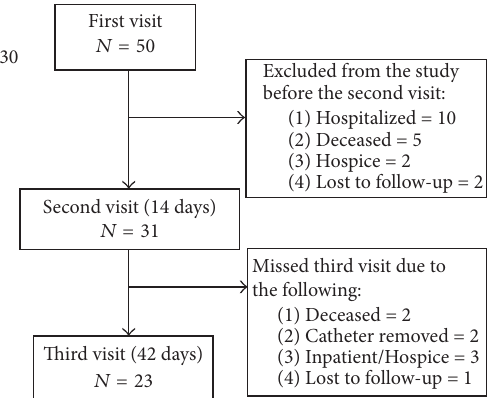
Figure 1: Course of the